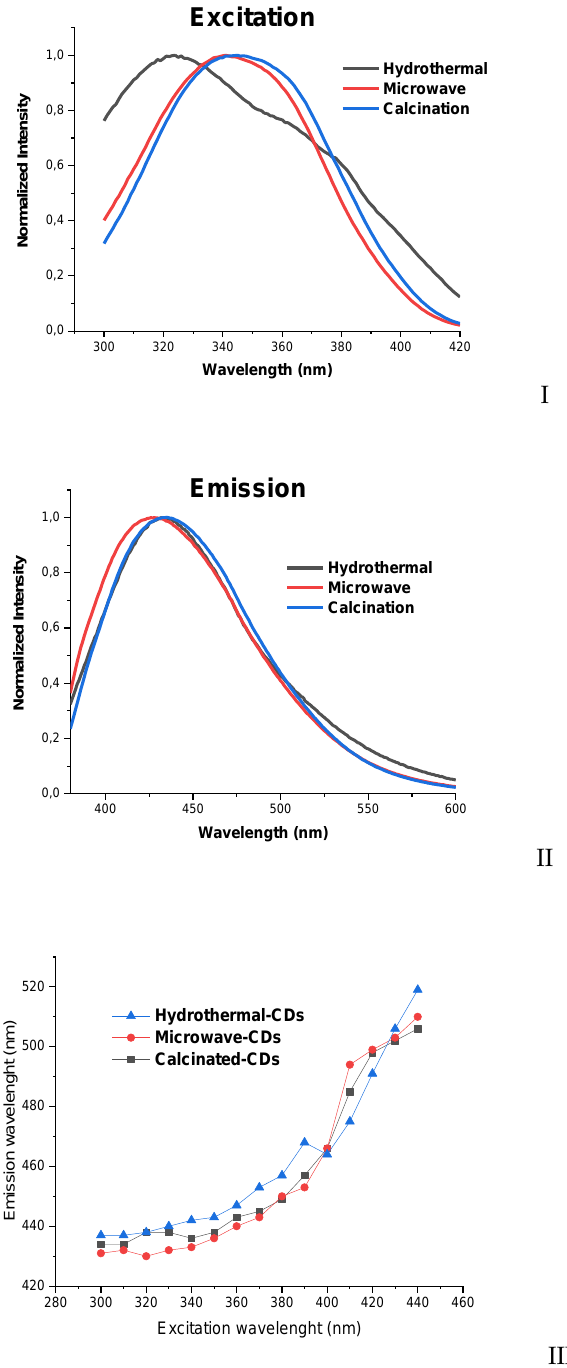
Figure 2. ( I ) Excitation- and ( II ) emission-spectra in aqueous solution from hydrothermal-, microwave-, and calcinated-CDs at 320, 340, and 330 nm excitation wavelength, respectively, and ( III ) emission wavelength (nm) as a function of the excitation wavelength